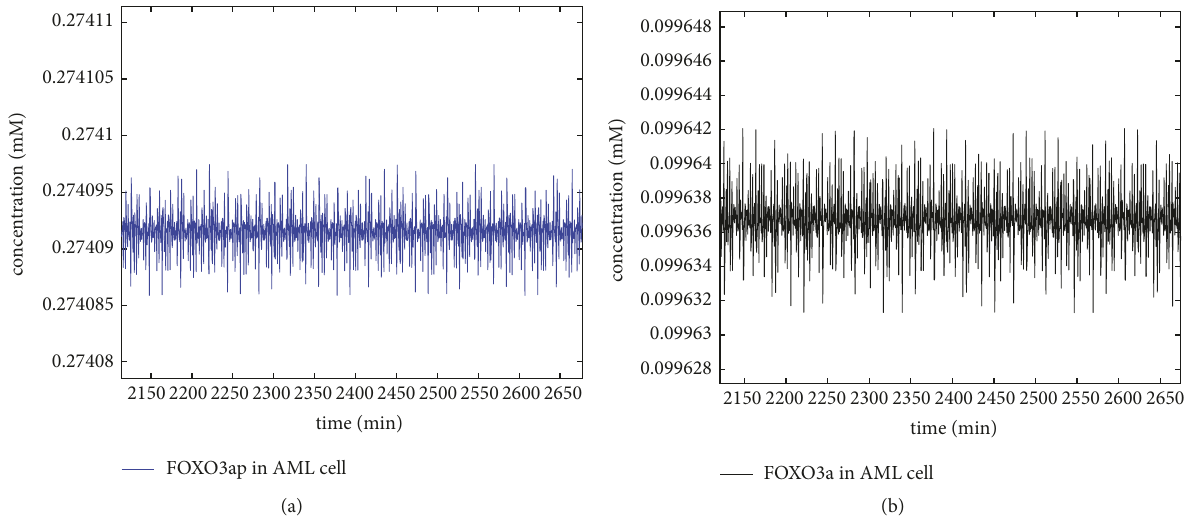
Figure 3: The oscillation of the FOXO3ap concentration (a) and FOXO3a concentration (b) in AML cell.